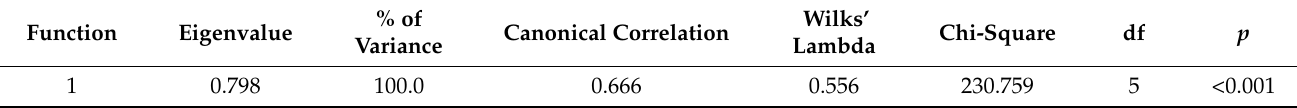
Table 2. Summary of the discriminant function.